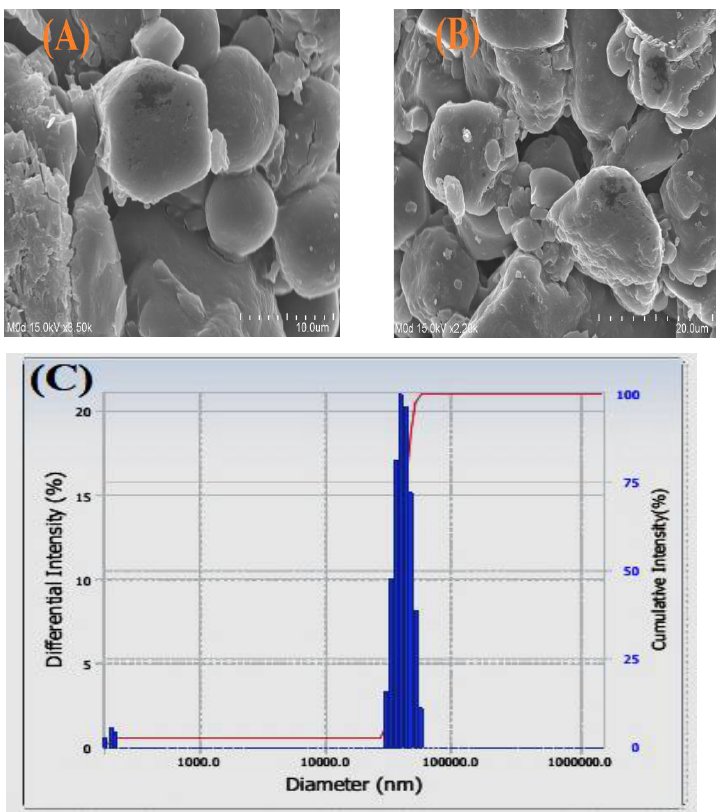
Figure 6. ( A , B ) Surface morphology of ASPA-pAMPS microgels (AFn-3), and ( C ) average particle size of ASPA-pAMPS